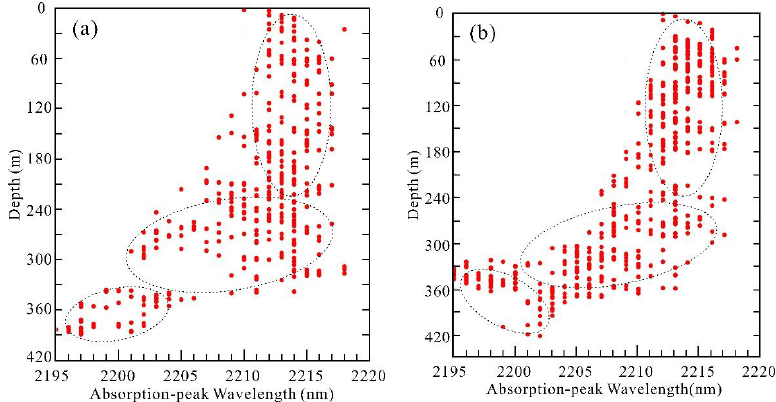
Figure 8. ( a ) Changes in the absorption-peak wavelength (1000–2500 nm) of illite at 2200 nm in drill holes ZK5432, ZK5630-1, ZK5234 and ZK5428. ( b ) Changes in the absorption-peak wavelength (1000–